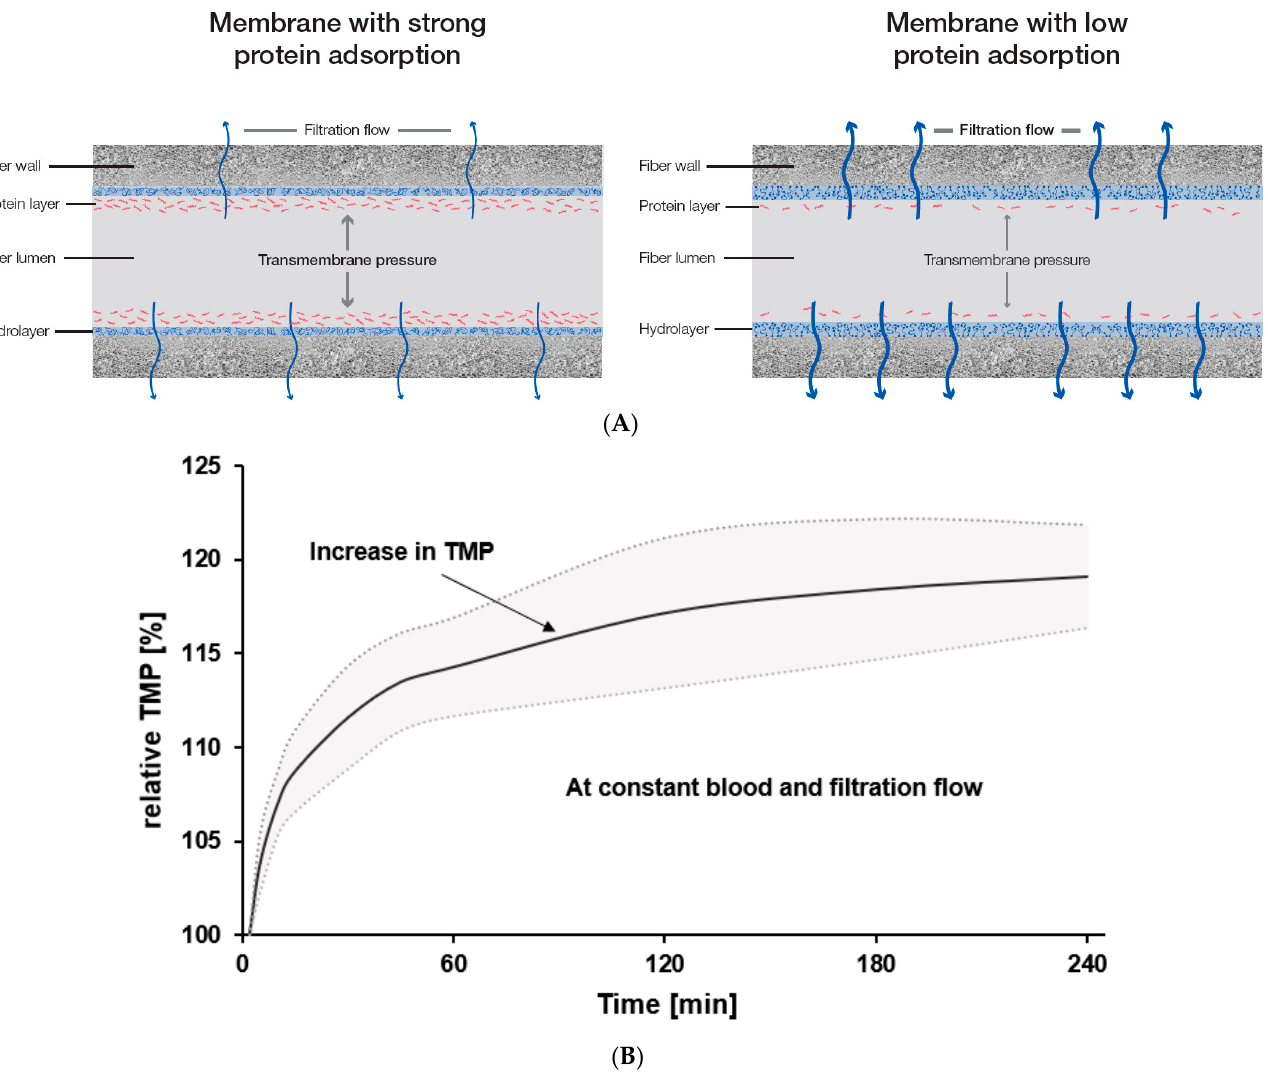
Figure 3. Impact of protein adsorption on the hydraulic characteristics of the membrane. ( A ) The membrane with strong protein adsorption (left) provides higher mass transfer resistance than the membrane with low protein adsorption (right), leading to a lower filtration flow rate and/or a higher transmembrane pressure (TMP). ( B ) At constant blood and filtration flows, the build-up of a secondary membrane leads to an increase in the TMP over the treatment time. Data were reanalyzed from a recently published study [24]. The solid line represents the mean value of three different dialyzers (FX CorAL (Fresenius Medical Care), ELISIO (Nipro), and xevonta (B. Braun); n = 3 for each dialyzer type), whereas the dotted line represents the standard deviations. Data were measured at the following time points: 2, 5, 10, 15, 30, 45, 60, 120, 180, and 240 min.